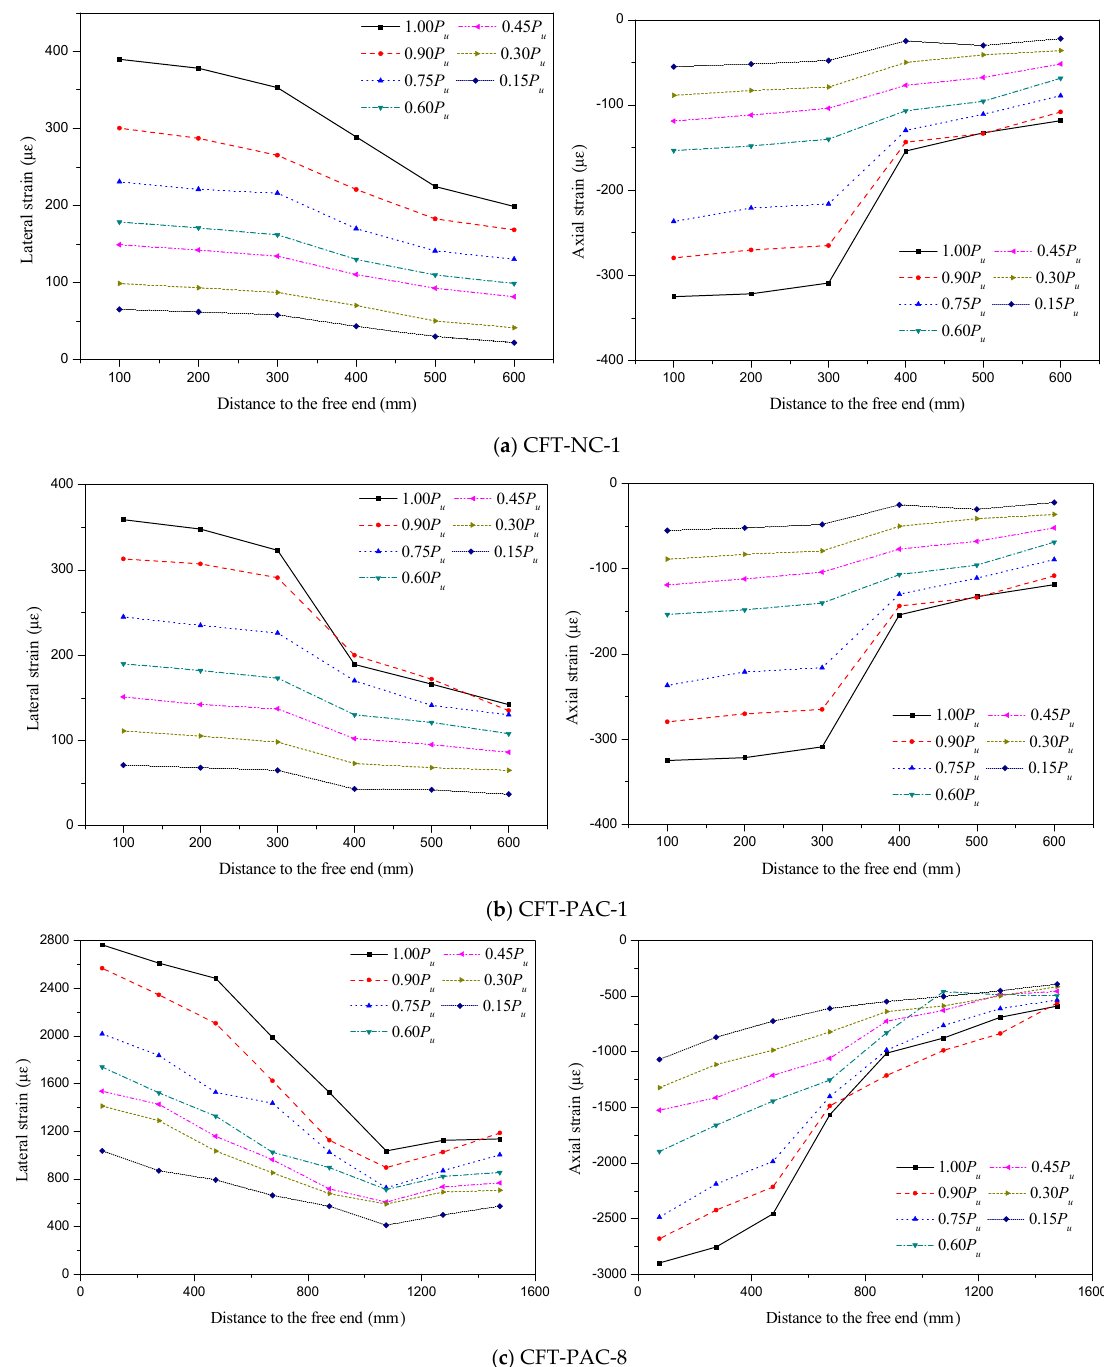
Figure 7. Typical lateral strain and axial strain distribution of the steel tube along the height. ( a ) CFT-NC-1; ( b ) CFT-PAC-1; ( c ) CFT-PAC-8.